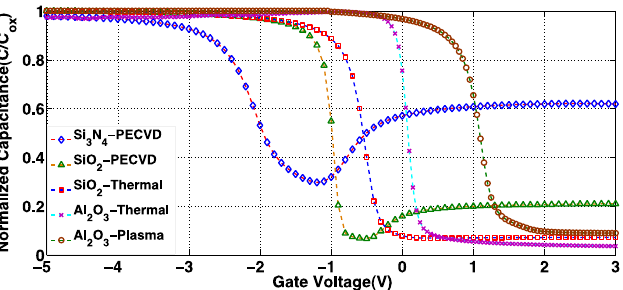
Fig. 2. Normalized C - V Characteristics of different dielectrics at 10 kHz to extract the fixed charge density ( Q f ).